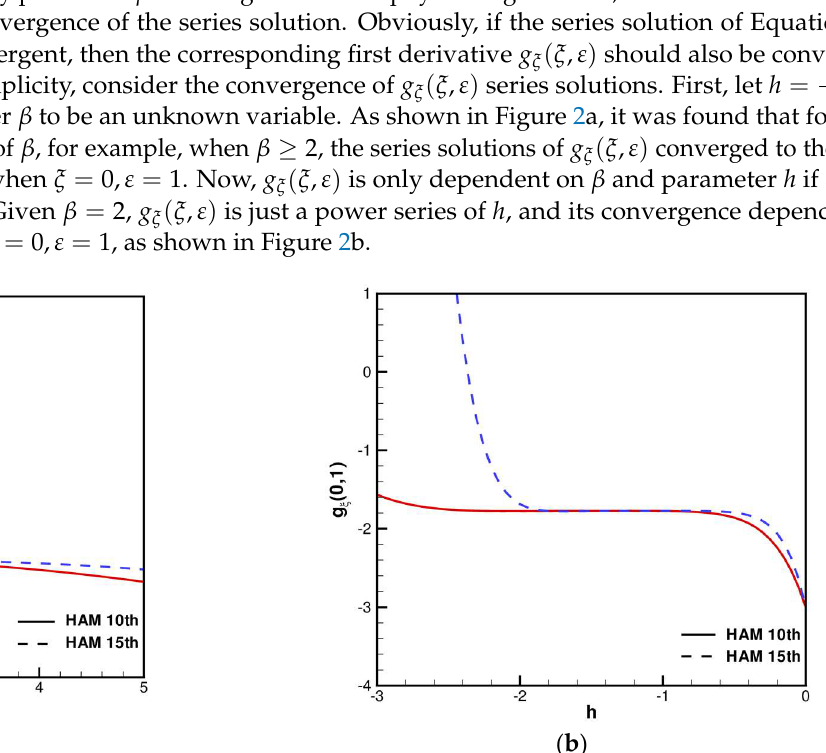
Figure 2. Curves of g ξ ( ξ , ε ) against β and h when ξ = 0, ε = 1: ( a ) 10th-order and 15th-order HAM approximations when h = − 1; ( b ) 10th-order and 15th-order HAM approximations when β = −